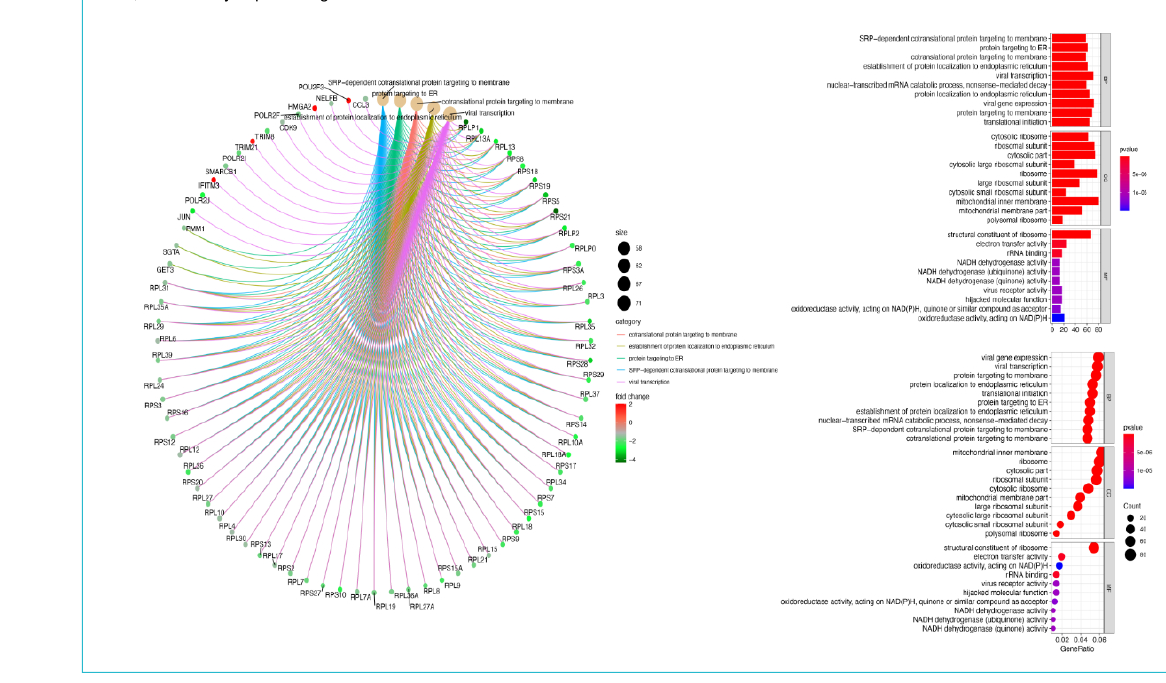
Figure 4: Top five enrichment results of the GO analysis of the DEGs in the yellow and grey modules. Abbreviations: GO, gene ontology; DEG, differentially expressed